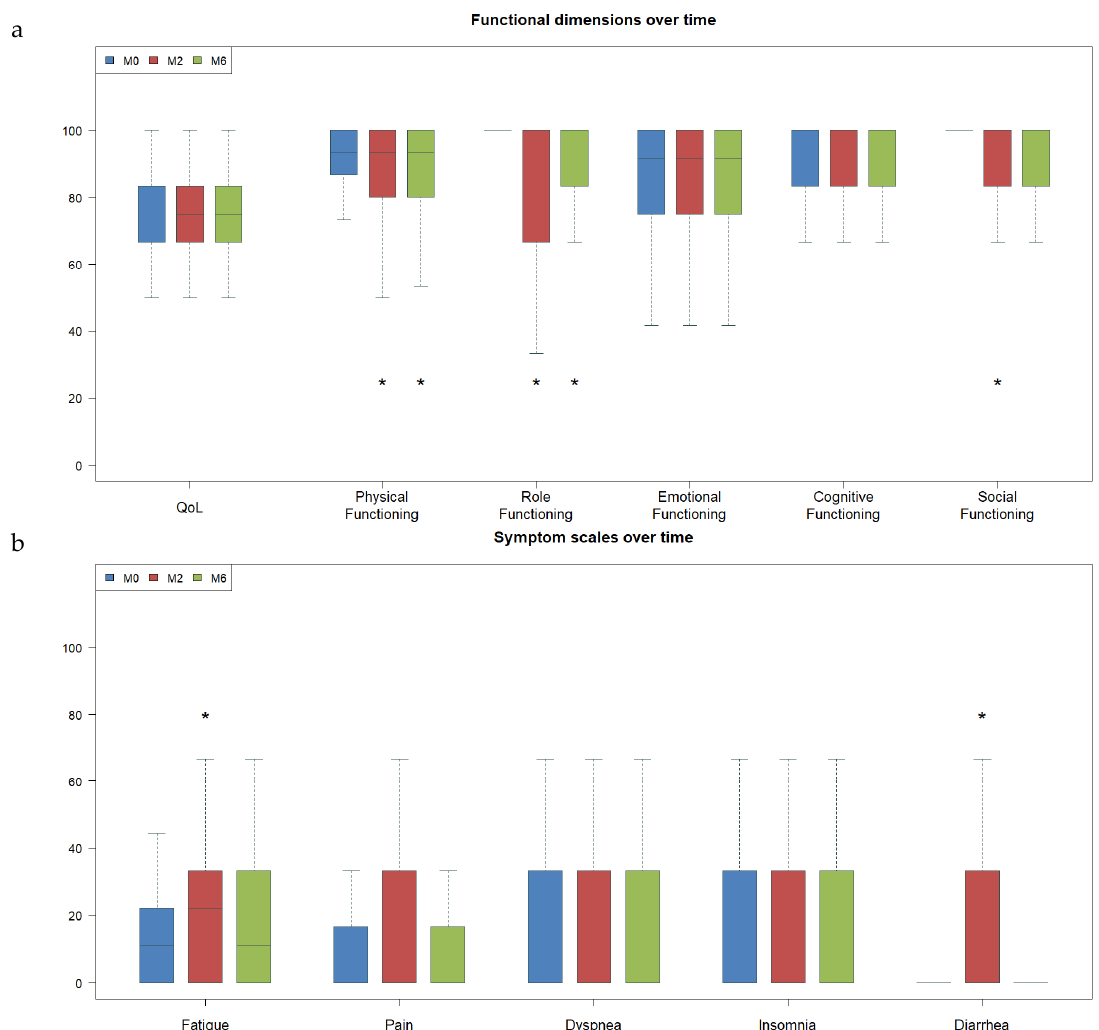
Figure 2. Quality of life over time (means comparison). For each item in the QLQ C30 questionnaire, we compared mean scores before, and two and six months after, radiotherapy. For the functional scales ( a ), higher scores represented better QoL. For the symptom scores ( b ), higher scores represented more severe symptoms and worse QoL. *Statistically significant variations ( p < 0.05). For symptom scales, items without any variations (nausea, appetite loss, constipation, and financial difficulties) have not been represented to make the figure easier to read.